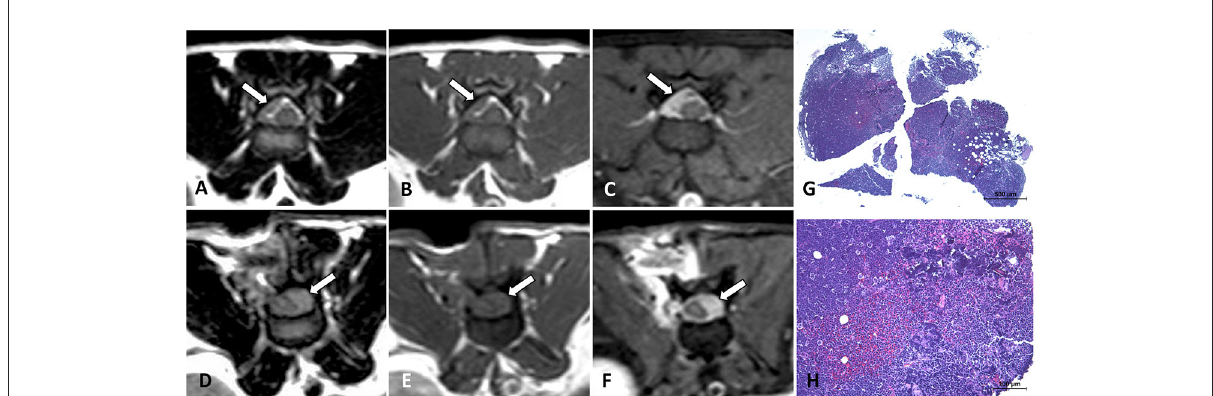
FIGURE6 MRI of a 4-year-old domestic short-haired cat with progressive ambulatory paraparesis for 7 days, diagnosed with large B-cell lymphoma. Transverse MRI of a cat at the level of the cranial portion of the L3 vertebral body (A–F) . There is an epidural dorsolateral right mass (arrows on A–C ) isointense on T2W (A) and T1W (B) images, which shows intense enhancement on post-contrast T1W SPIR image (C) and induces mild spinal cord contralateral displacement. The images (D–F) correspond to the same plane and sequences as (A–C) , respectively, 18 days later after a right hemilaminectomy for decompression and tissue sampling was performed. A left epidural lesion was found (arrows on D–F ) inducing a greater spinal cord compression. Tissue biopsy (G,H) HE, neoplastic lymphoid cells including basophilic (dark blue) necrotic foci and mixed with infiltrating